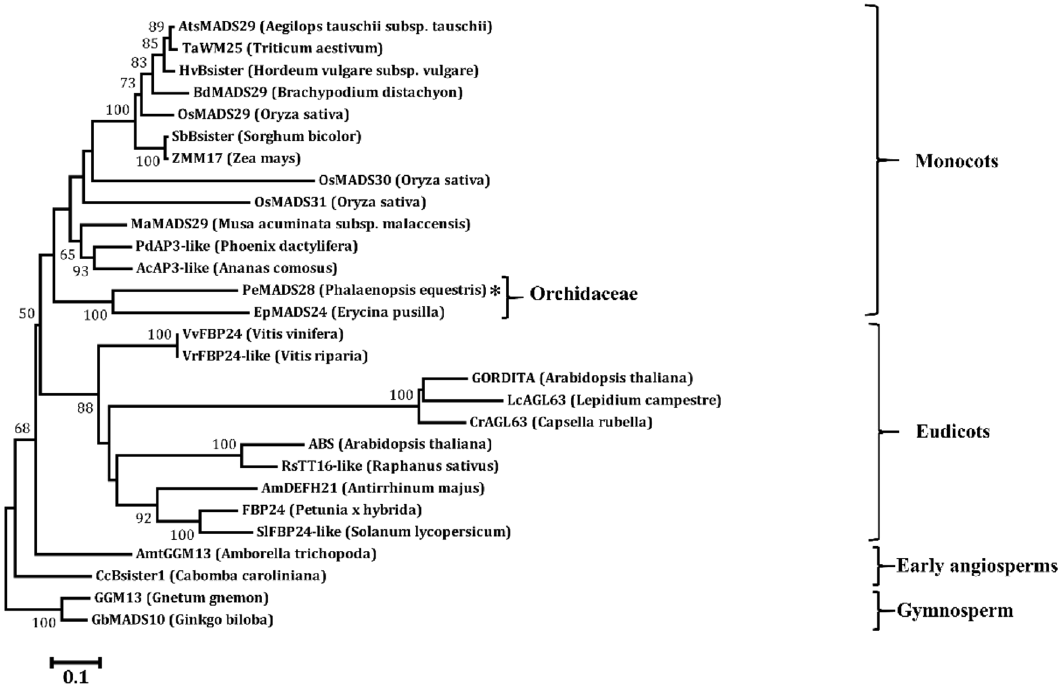
Figure 1. Phylogenetic analysis of B sister proteins. GGM13 from Gnetum gnemon and GbMADS10 from Ginkgo biloba were outgroup representatives. Bootstrap values from 1000 replicates are indicated on most major nodes. PeMADS28 is highlighted by the